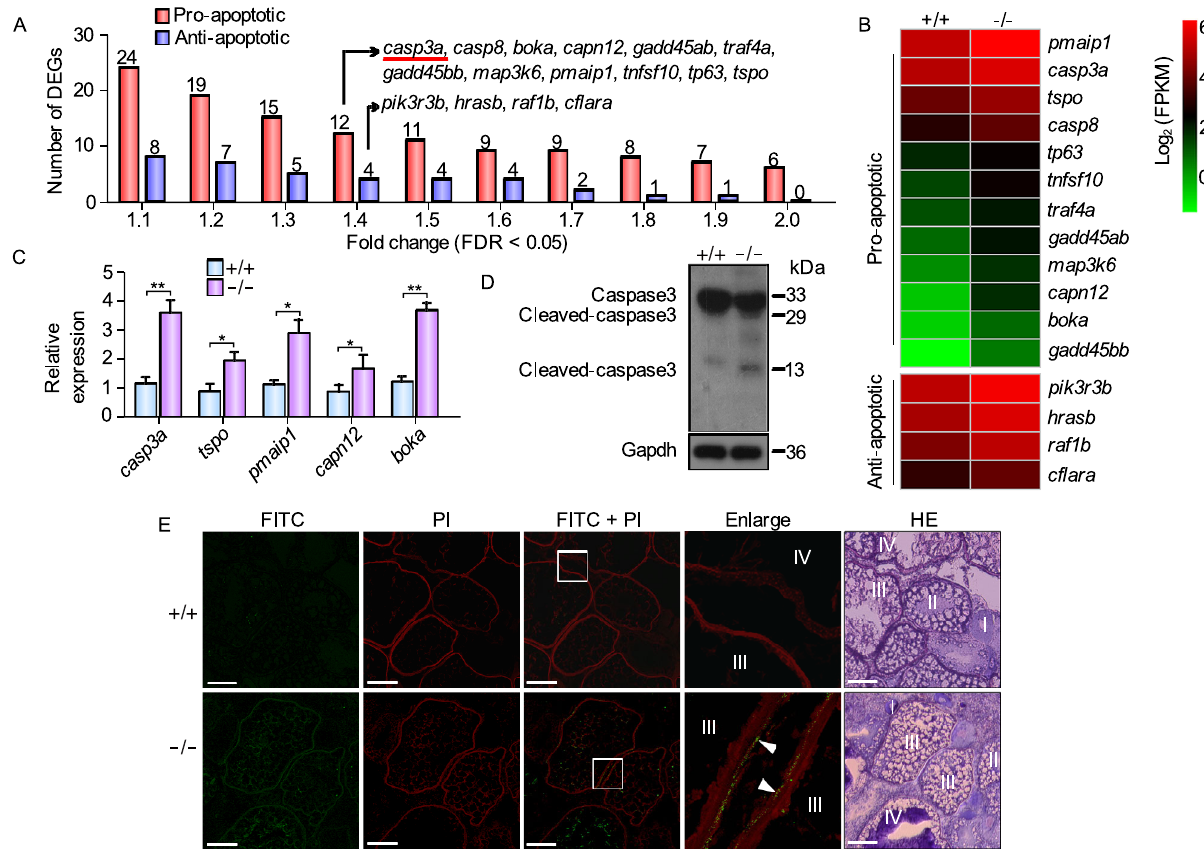
Figure 4. Up-regulated apoptosis in the sox3 − / − ovaries in comparison with wild type ovaries. (A) Statistical analysis of the apoptosis-related DEGs (FDR < 0.05) in both sox3 +/+ and sox3 − / − based on KEGG analysis. Red bars indicated pro-apoptotic genes and blue bars represented anti-apoptotic genes. The genes with fold change of 1.4 were listed. (B) Hierarchical clustering indicated the expression levels of apoptosis-related DEGs between sox3 +/+ and sox3 − / − ovaries. (C) Quantitative real-time PCR analysis of selected genes to validate the DEGs from RNA-seq data. The transcript levels were related to β -actin expression. Relative level, 2 − ΔΔ Ct . T-test was performed. * P < 0.05; ** P < 0.01. (D) Western blot analysis showed that cleaved-caspase3 were up-regulated in the sox3 − / − ovaries in comparison with the wild type ovaries. Gapdh was used as an internal control. (E) TUNEL analysis. In follicles of stages III and IV, obvious signals (FITC-labeled, green) were observed in somatic cells (theca cells and granulosa cells) (white arrowheads) of sox3 − / − ovaries. The nuclei were stained by PI (red). The enlarged images originated from the white squares. The ovaries sections were stained by H.E. and showed on the right. Scale bar: 100